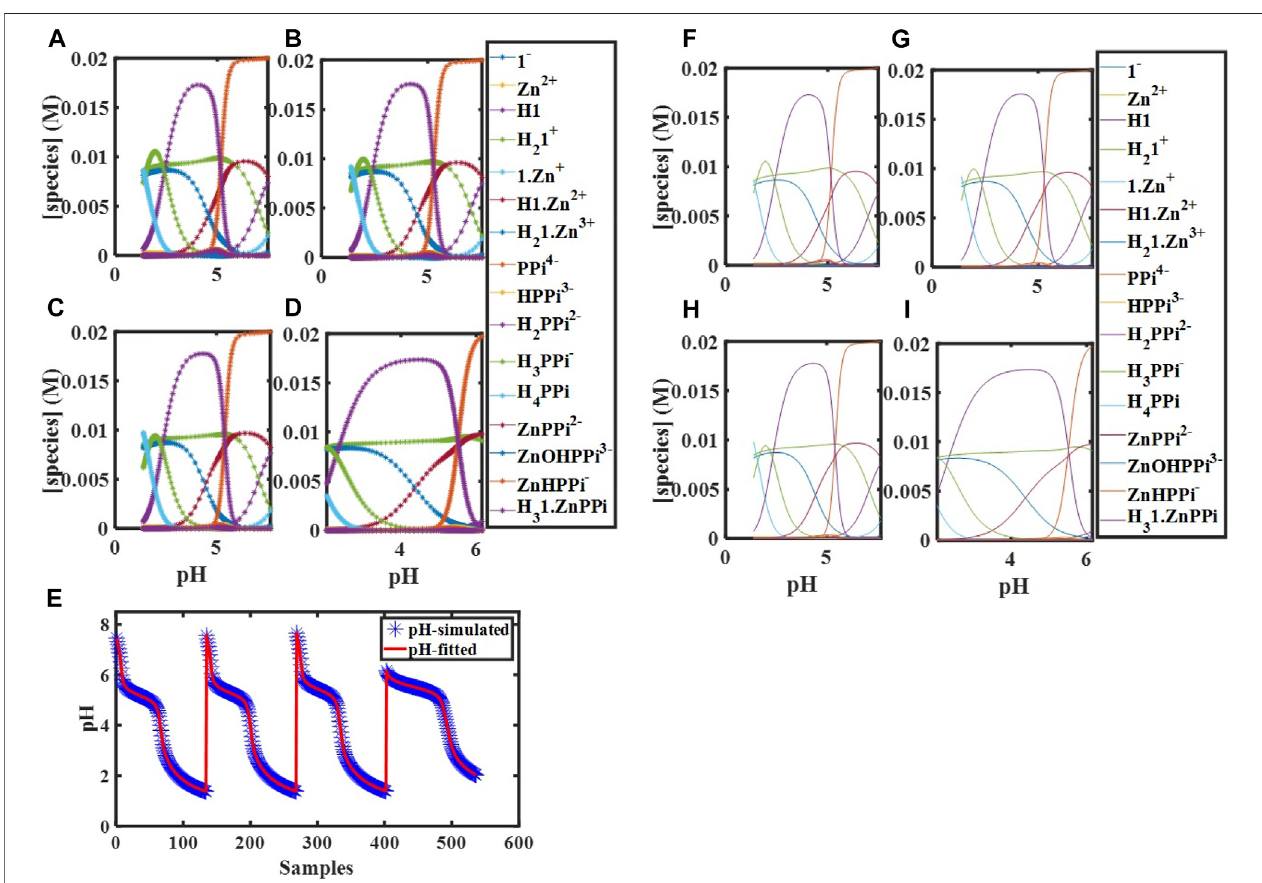
FIGURE 2 | Simulated concentration pro fi les for [ Zn ] 0 tot (cid:1) [ PPi ] 0 tot (cid:1) 20.00 mM, [ 1 ] 0 tot (cid:1) 10.00 mM, [ H ] 0 tot (cid:1) 0 at (A) 283 K, (B) 288 K, (C) 293 K, and (D) for [ Zn ] 0 (cid:1) [ PPi ] 0 (cid:1) 20.00 mM, [ 1 ] 0 (cid:1) 10.00 mM, [ H ] 0 (cid:1) 10.00 mMat298 K; (E) Simulatedand fi ttedpHfor[ d 283 tot tot tot tot pro fi les of species obtained using global analysis corresponding to (F) 283 K, (G) 288 K, (H) 293 K, and (I) 298 K.